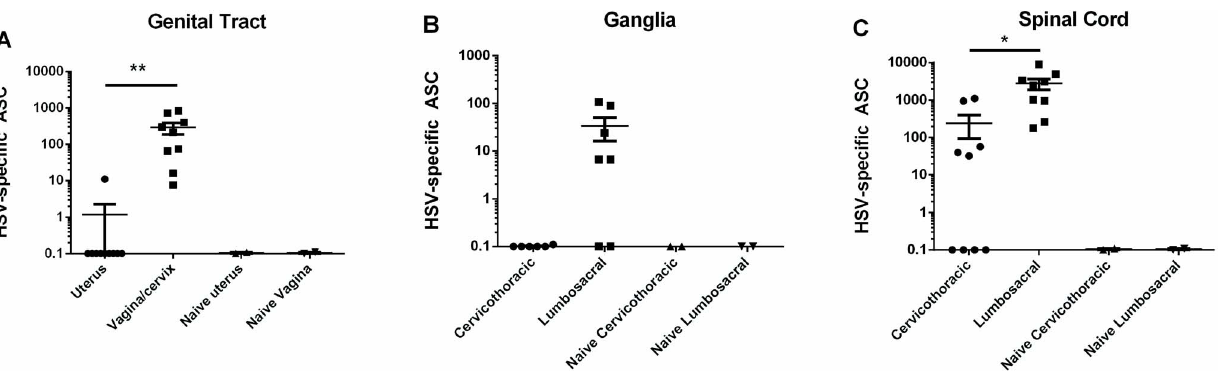
Fig. 2. Location of HSV-specific, tissue-resident ASCs in guinea pigs infected previously with HSV-2. Hartley guinea pigs were infected ivag with HSV-2 strain MS and lymphocytes isolated from the indicated tissues on days 48–57 post infection. HSV-specific ASCs were quantified by ELISPOT on HSV-2 glycoprotein-coated plates. Each data point represents results from an individual animal. (* P , 0.05; ** P , 0.01, Student’s t